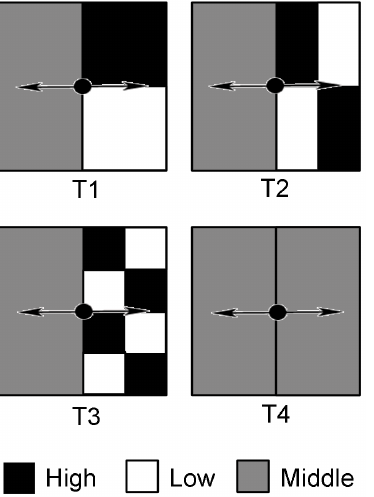
Figure 1. Experimental design. The boxex used in this study were 100 6 100 6 25 cm in size. Three scales of heterogeneous nutrient treatments and one homogeneous nutrient treatment, coded as T1, T2, T3 and T4, were implemented in the boxes. The box was divided into two parts, one was filled with homogeneous nutrient and the other with 3 scales of heterogeneous nutrients (the three small boxes were divided respectively into two, four and eight patches, half of patches in each small box were filled with high nutrient and the other half low nutrient).